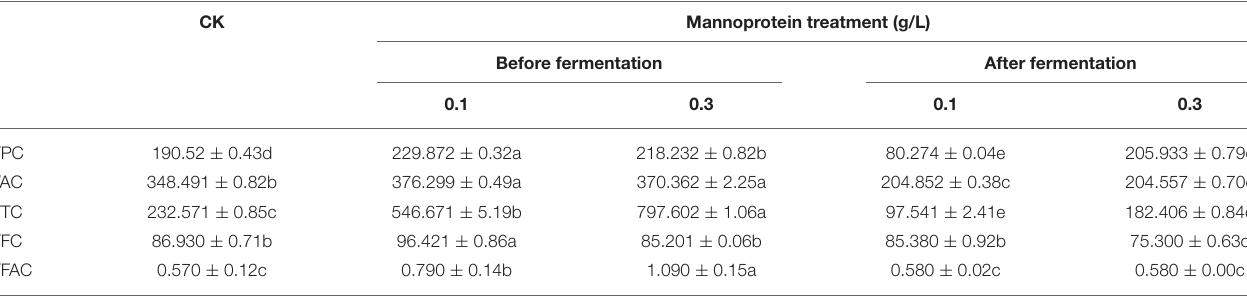
TABLE 1 | Effects of mannoprotein concentration on the polyphenols of wine at different stages of fermentation